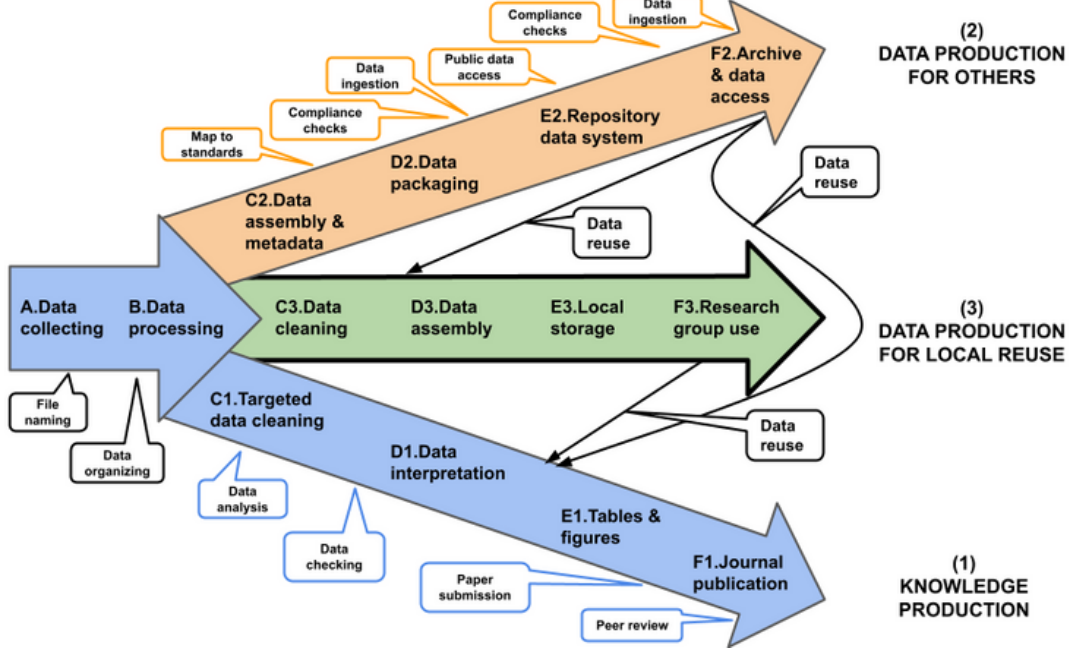
Figure 5. Three-Stream Model of Knowledge and Data